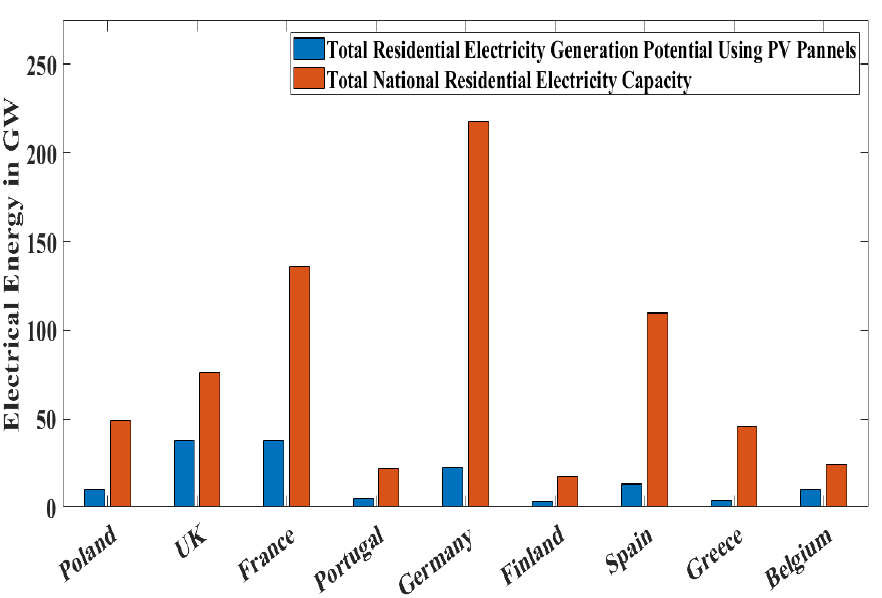
Figure 1. Residential PV electrical generation potential versus the total national electricity generation capacity in the